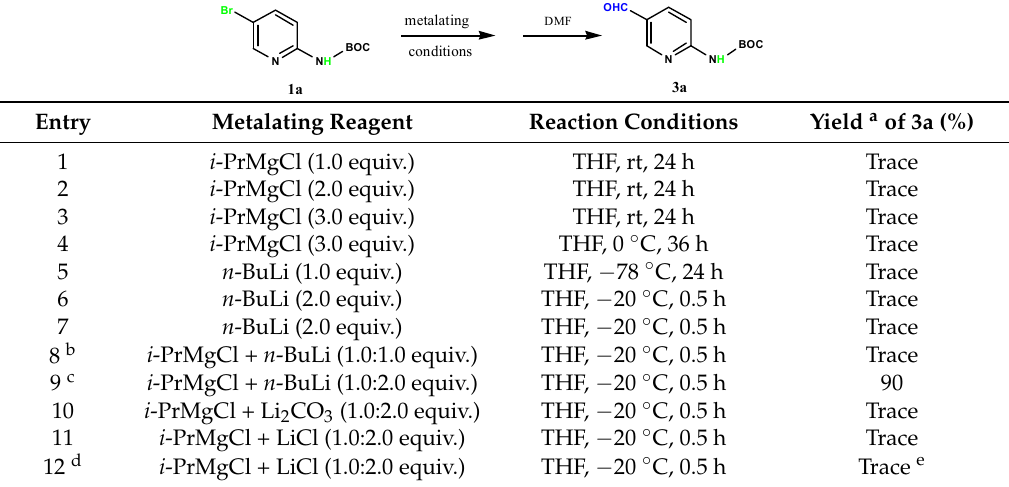
Table 1. Tert-butyl (5-formylpyridin-2-yl) carbamate of metalating reagents prepared from 2-( N -BOC-amino)-5-bromopyridine. 2-( N -BOC-amino)-5-bromopyridine.